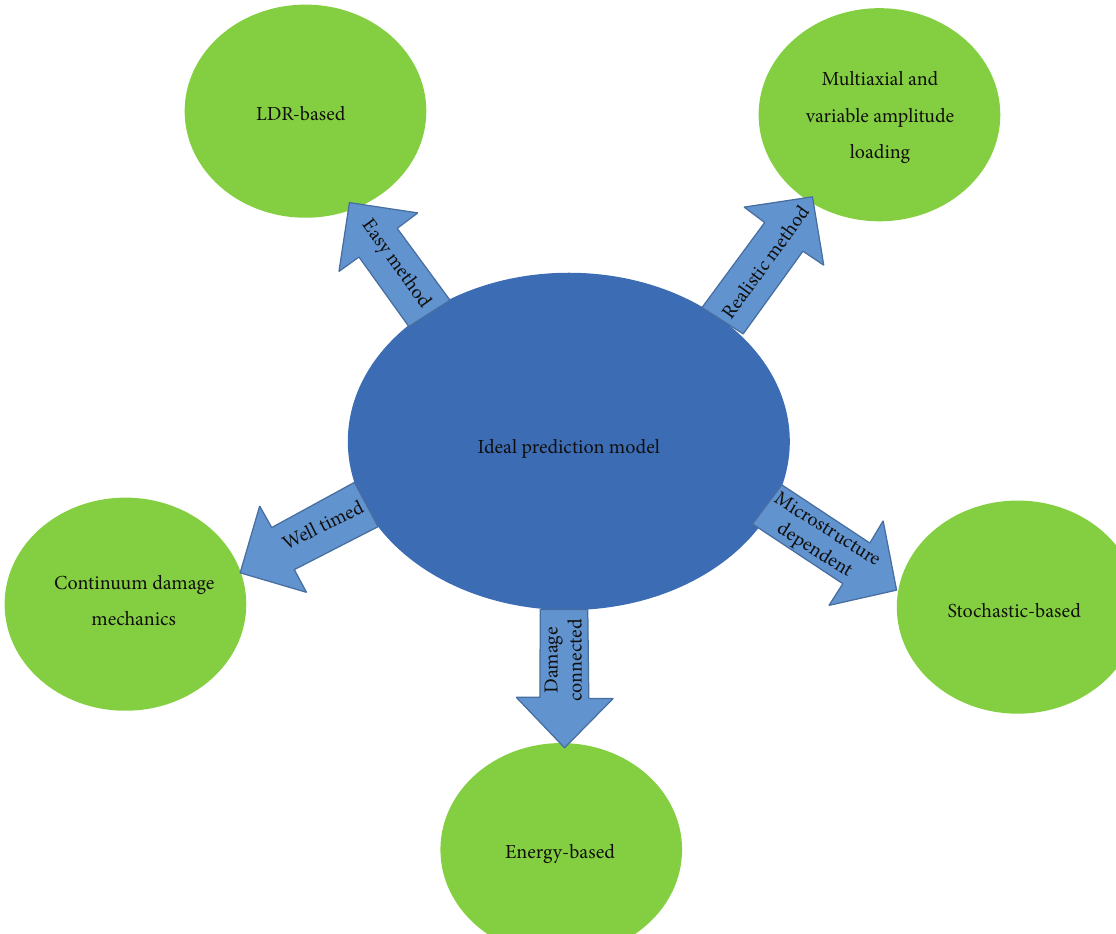
Figure 8: Features of an ideal fatigue life prediction